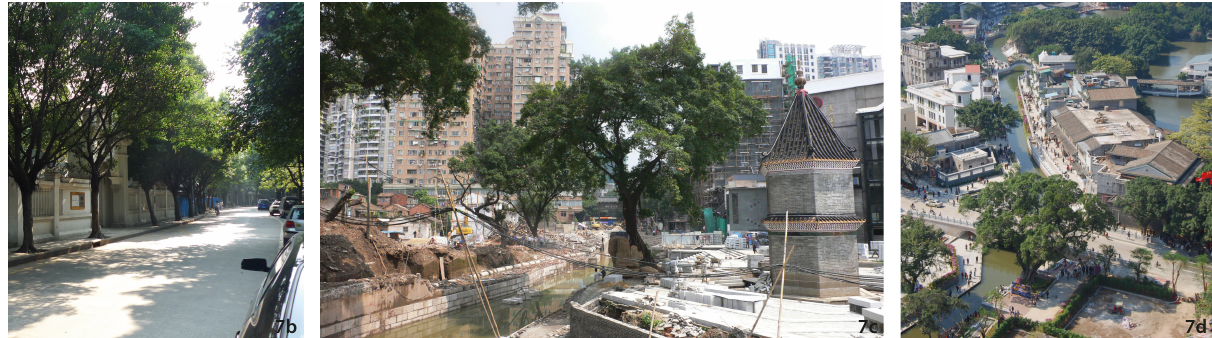
Figure 7a Uncovering of Litchi Bay Canal, landscape design of Litchi Bay Canal (Source: Yang